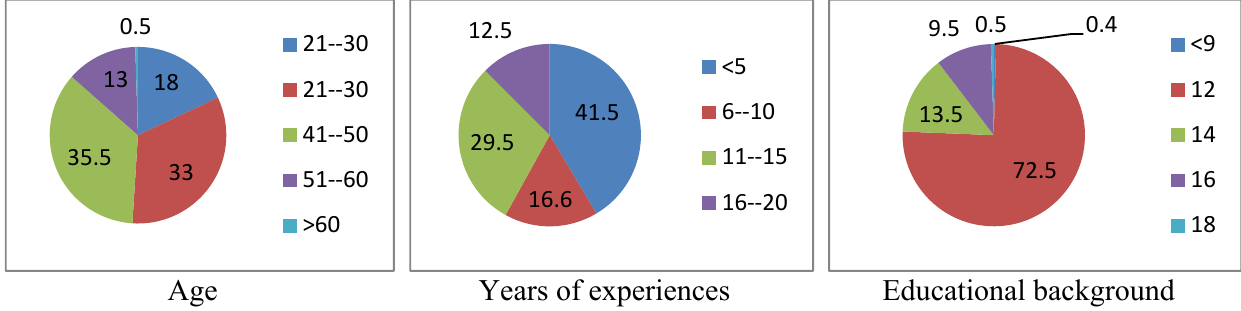
Fig. 1. Personal characteristics of the